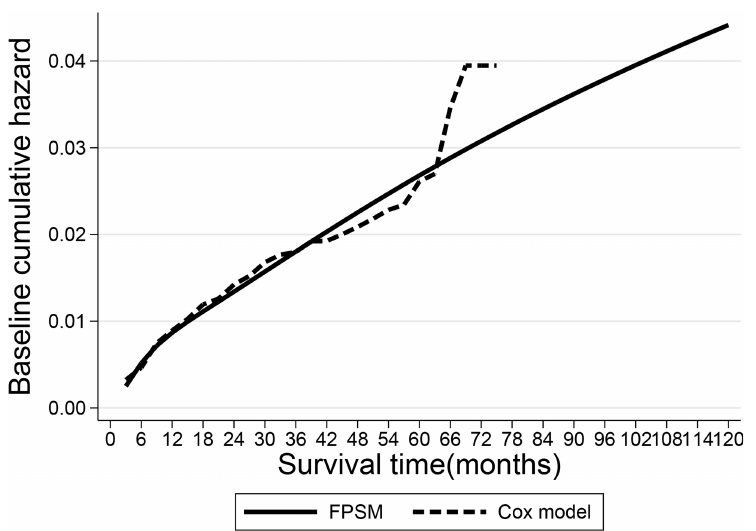
Fig 2. Comparison of the baseline cumulative hazards of the Cox model and flexible parametric survival